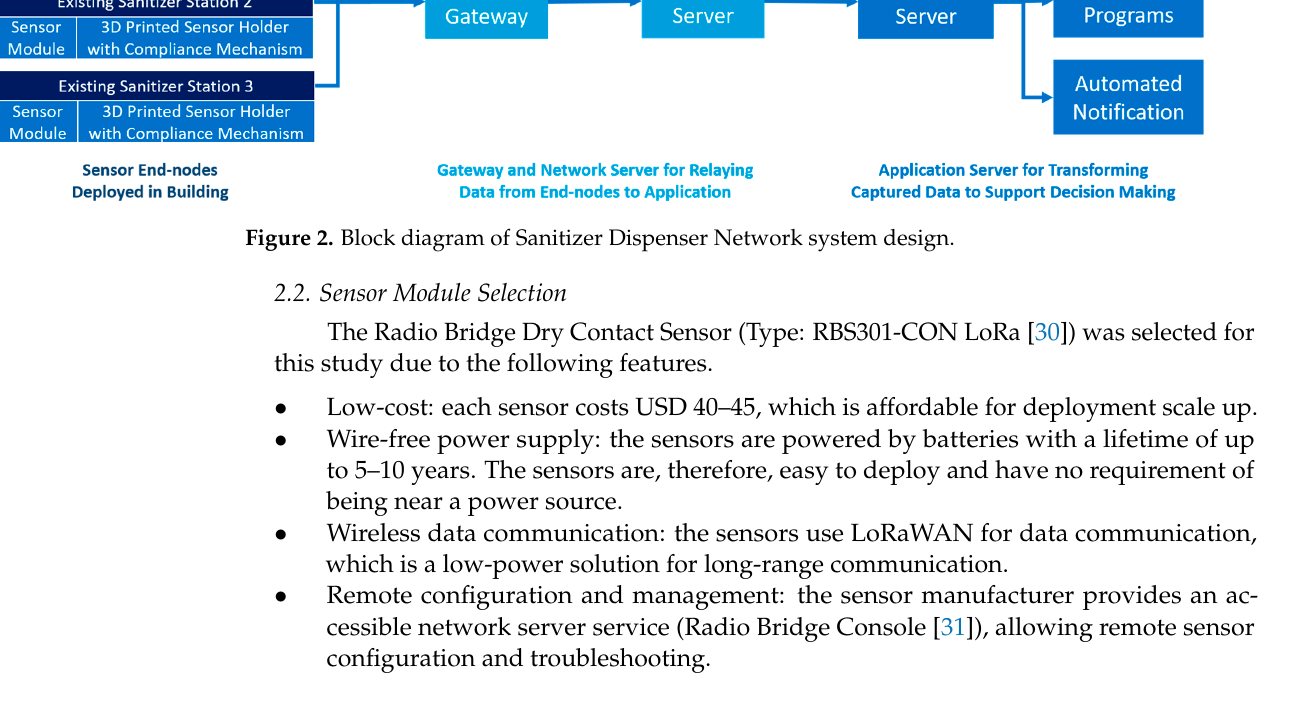
Figure 1. Motivation for the proposed approach.